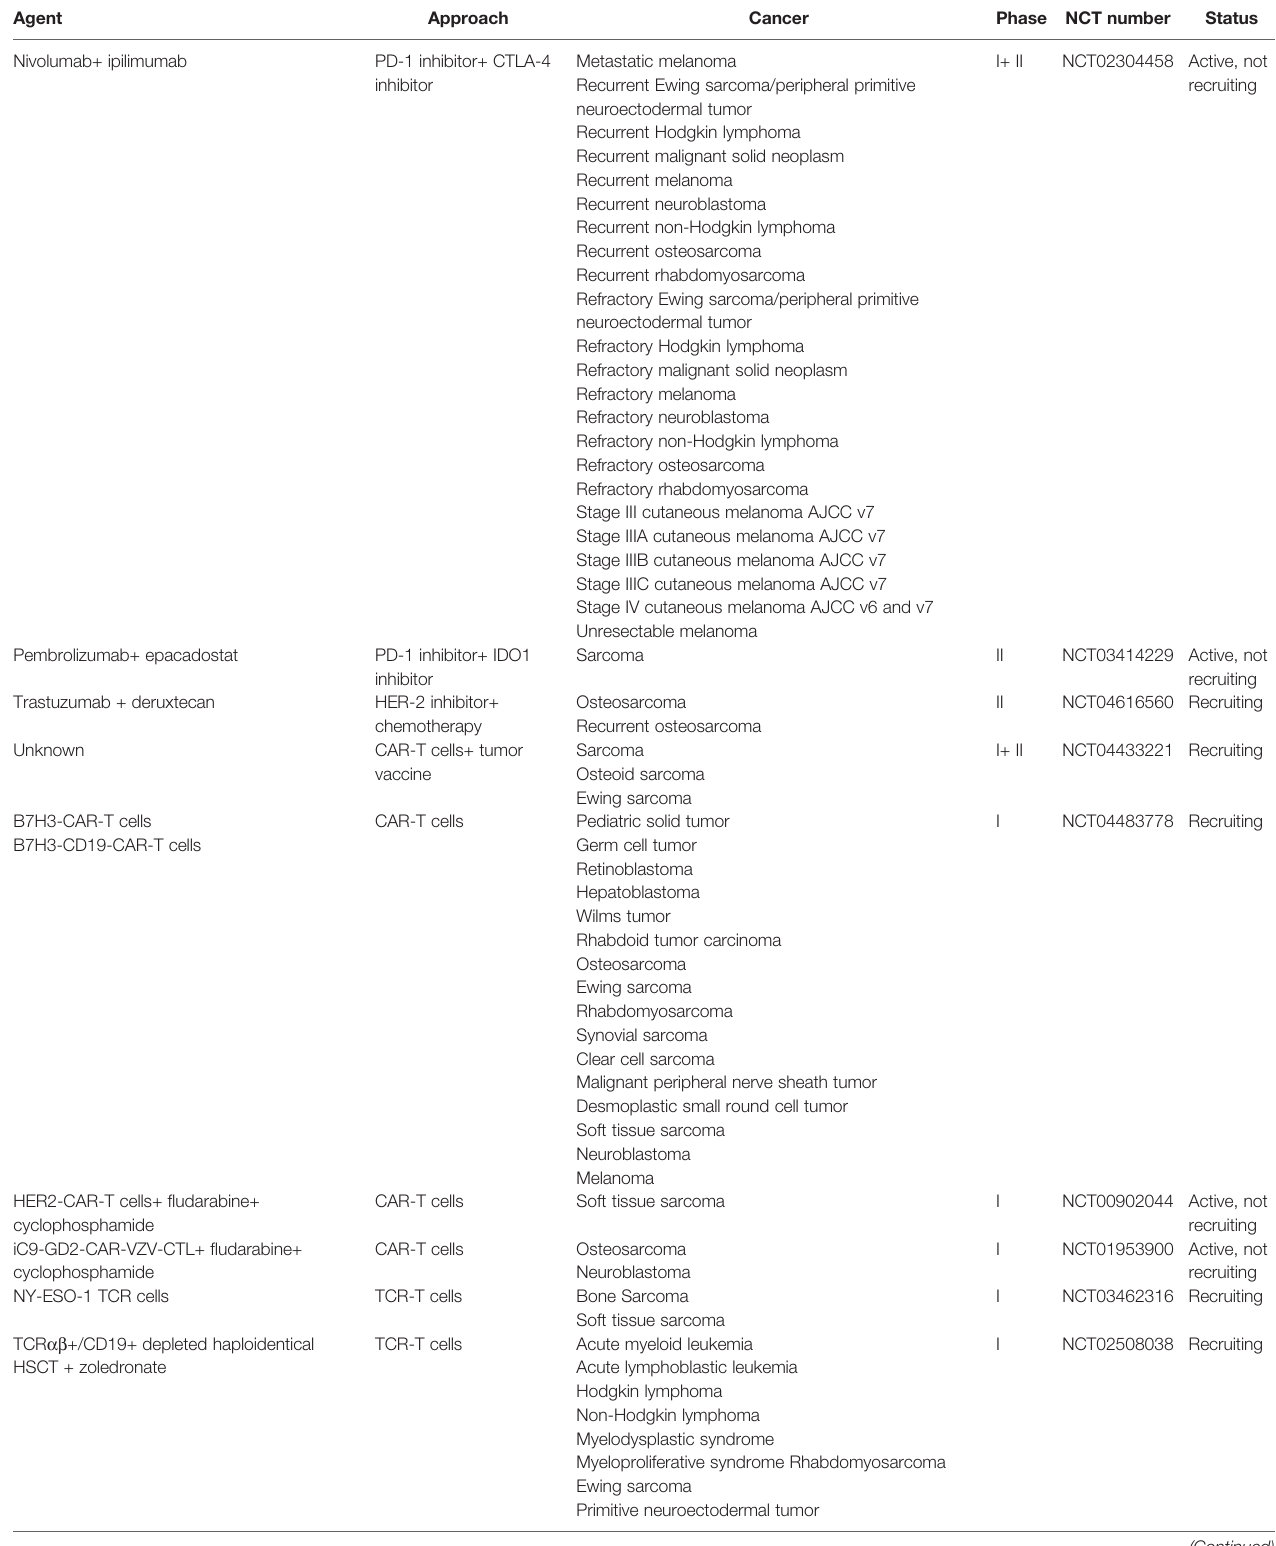
TABLE 3 | Some ongoing or planned clinical trials of novel